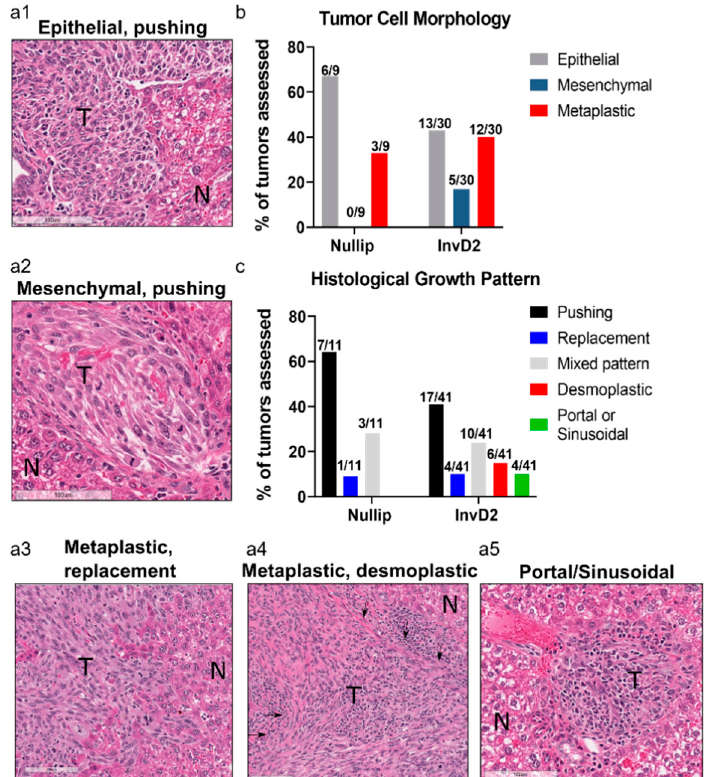
Figure 2. Histology of murine mammary liver metastases resembles human disease and shows increased histological heterogeneity in involution hosts. Representative hematoxylin and eosin stained images from D2.OR tumors classified as ( a1 ) epithelial, pushing, ( a2 ) mesenchymal, pushing, ( a3 ) metaplastic, replacement, ( a4 ) metaplastic, desmoplastic with desmoplastic areas noted by black arrows, and ( a5 ) portal/sinusoidal pattern. Tumors are denoted by “T” and adjacent normal liver by “N”; ( b ) Quantitation of D2.OR tumor cell morphology and ( c ) histological growth pattern by host reproductive